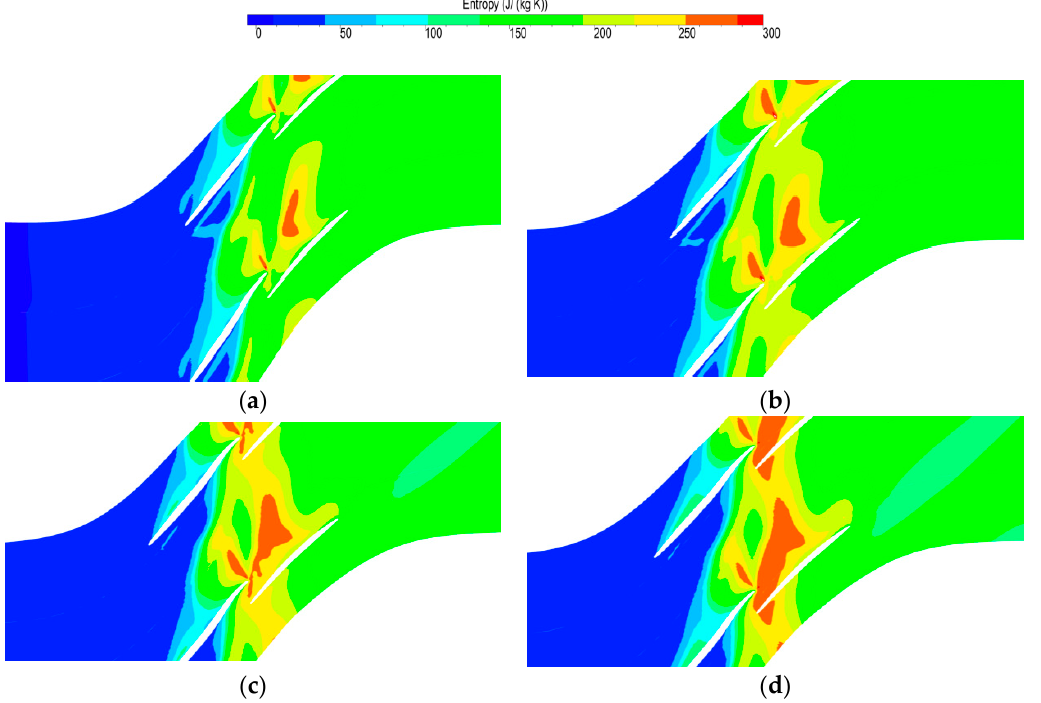
Figure 14. Comparison of the entropy diagram of the casing wall of NB10, NB20, and NB30. ( a ) ORG. ( b ) NB10. ( c ) NB20. ( d ) NB30.